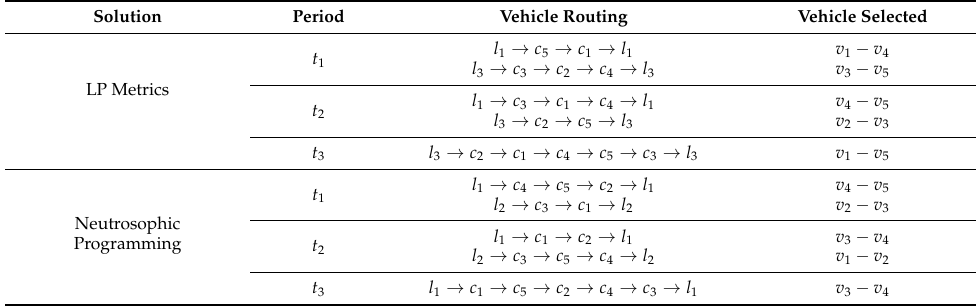
Table 7. Optimal transport routing obtained in the sample problem.